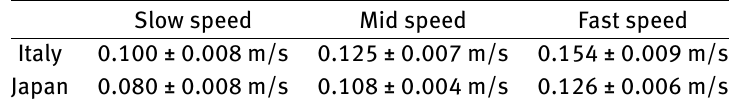
Table 1: Robot hand speed in the different experimental conditions: average and standard deviation.